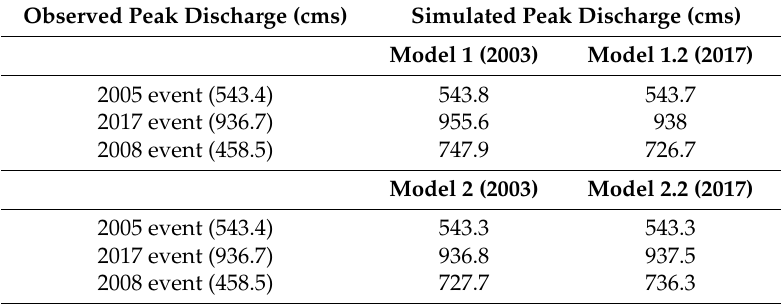
Table 8. Simulated peak discharge under 2003 and 2017 LULC conditions at the Blue River